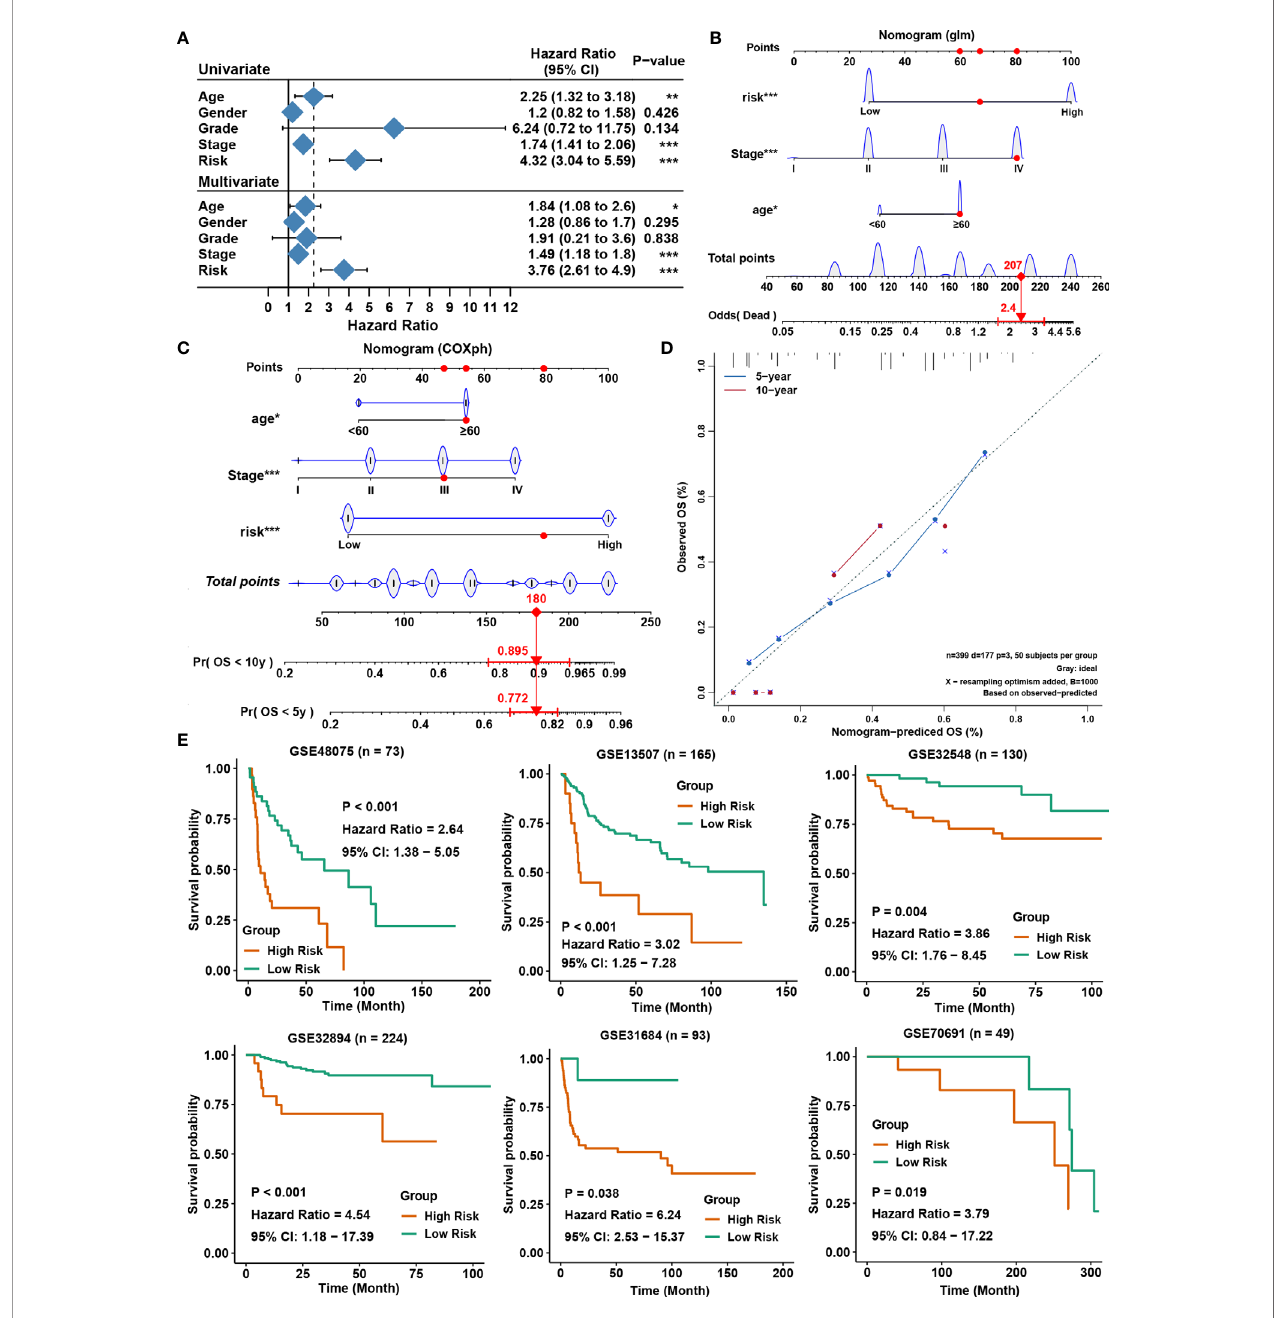
FIGURE 4 | Construction of a predictive nomogram and external validation. (A) Univariate and multivariate Cox analyses of clinicopathological characteristics and gene signatures with overall survival in the TCGA BLCA cohort. (B) Nomogram to predict the odds of mortality of BLCA patients. (C) Nomogram to predict the 5 ‐ y and 10 ‐ y overall survival of BLCA patients. (D) Calibration curve for the overall survival nomogram model in the TCGA BLCA cohort. The dashed diagonal line represents the ideal nomogram, and the blue line and red line represent the 5 ‐ y and 10 ‐ y observed nomograms, respectively. (E) Validation of the writer-related gene signature in six external BLCA datasets for overall survival. *P < 0.05, **P < 0.01, ***P <